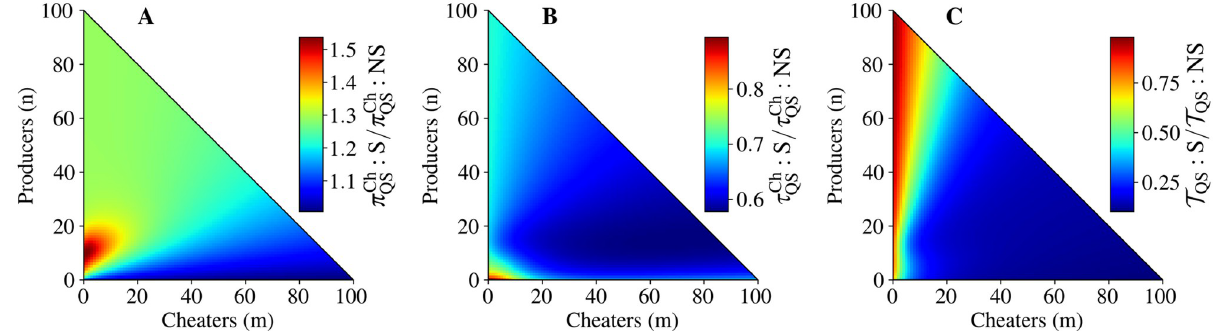
Fig 5. Cheater autoinducer production is destructive in the presence of an alternative source of nutrition ( λ 0 = 0.2). The ratio of A) cheater fixation probability, B) cheater mean fixation time, and C) mean extinction time between QS populations where cheaters signal (indicated by S ) to where cheaters do not signal (indicated by NS ). The non-signaling results used in the denominators are the same as those in Fig 3. See S1 Table for parameter values.